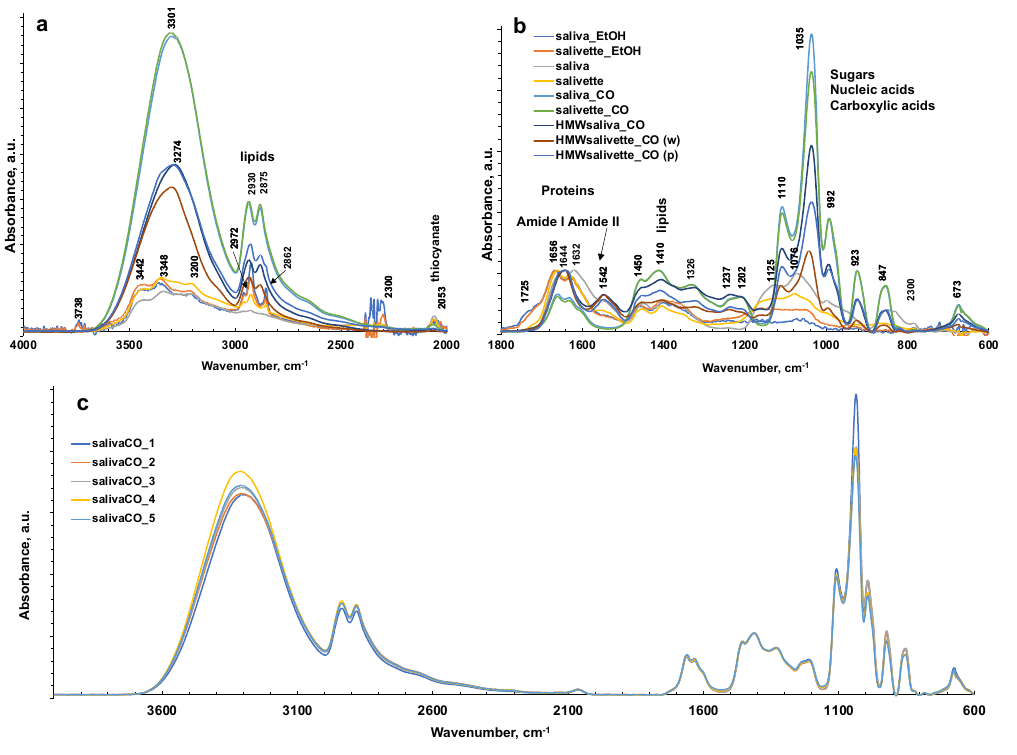
Figure 3. ATR-FTIR spectra of all representative saliva samples analyzed before and after depro- teinization with ethanol (EtOH) and ultrafiltration with 3000 Da cut-off (CO) in 4000-2000 cm − 1 ( a ) and 1800-600 cm − 1 regions ( b ). ( c ) ATR-FTIR of N = 5 replicates of saliva sample after ultrafiltration with 3000 Da cut-off as example of reproducibility of the spectra. HMWsaliva_CO and HMWsalivette_CO refer to high-molecular-weight (HMW) compounds remaining in the upper part of 3 kDa cut-off filtering units (w = wiping, p = printing) as explained in the experimental part.